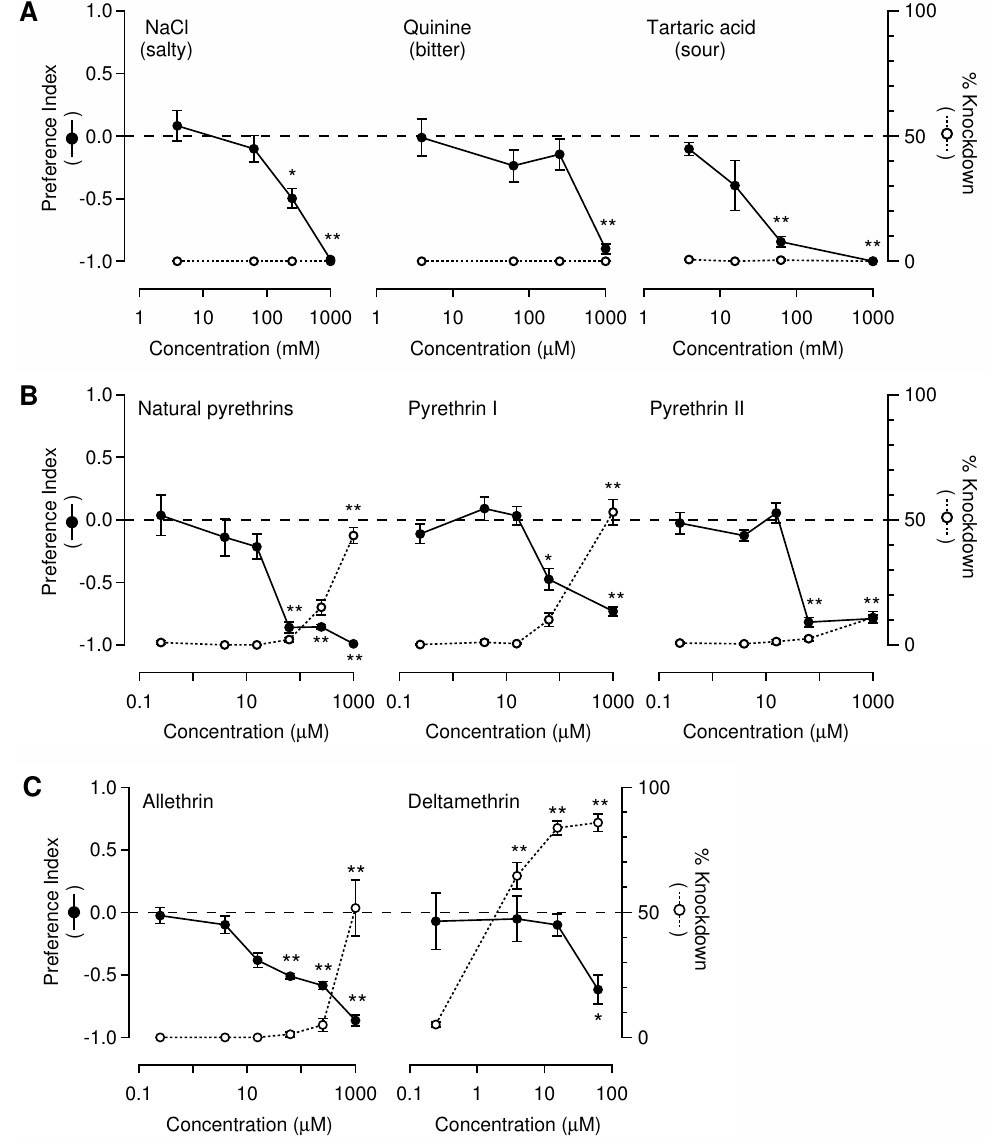
Figure 3. Feeding deterrence of neurotoxic insecticides and known anti-tastants in dual-choice feeding assays. Paired-choice experiments revealed a preference of blowflies for 0.1 mM sucrose solution over 0.1 mM sucrose solution mixed with various concentrations of test compounds. Preference indexes (PIs) and knockdown (KD) rates are indicated as a function of treatment concentrations for: ( A ) salty, bitter, and sour tastants; ( B ) pyrethrins, and synthetic pyrethrins I and II; ( C ) pyrethroid insecticides. Error bars indicate standard error of the mean ( n = 5 repetitions), and asterisks denote significant differences from PI = 0 and 0% KD rate, according to a one-sample t -test with Bonferroni correction; * p < 0.05, ** p < 0.01.